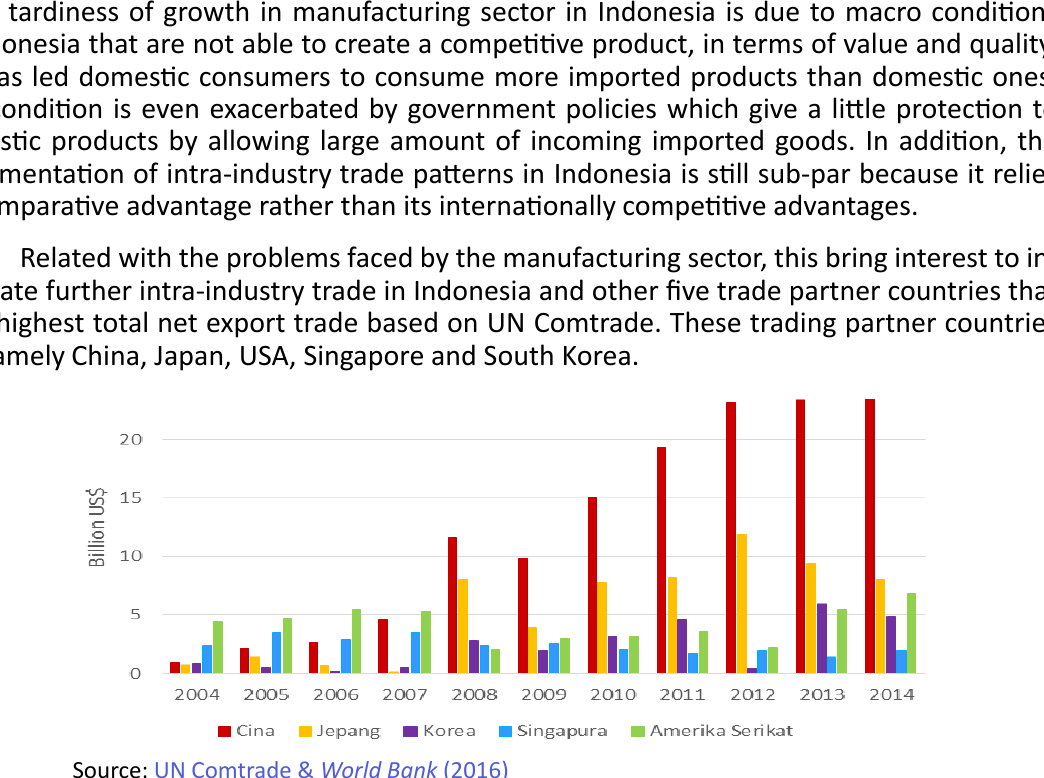
Figure 1: Total Trade between Indonesia and its Trading Partner Countries circa